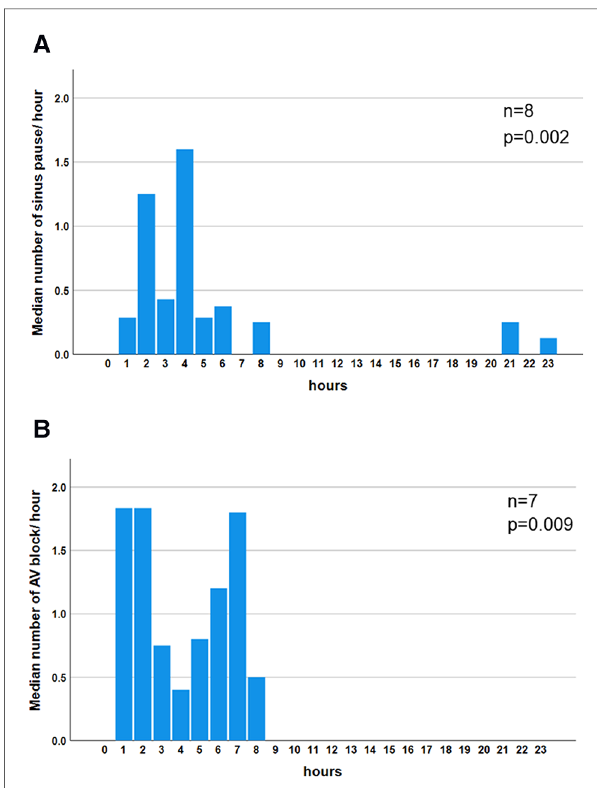
FIGURE 1 Diurnal variation in the median number of bradyarrhythmias. Signi fi cant night-time dominance was observed in the diurnal variation of the median number of sinus pauses ( P =0.002) ( A ). Signi fi cant night-time dominance in the diurnal variation of the median number of atrio- ventricular blocks ( P =0.009) ( B ). Comparisons of frequencies among each hour in sinus pause and AV block were performed using the Kruskal – Wallis test. AV block: atrio-ventricular